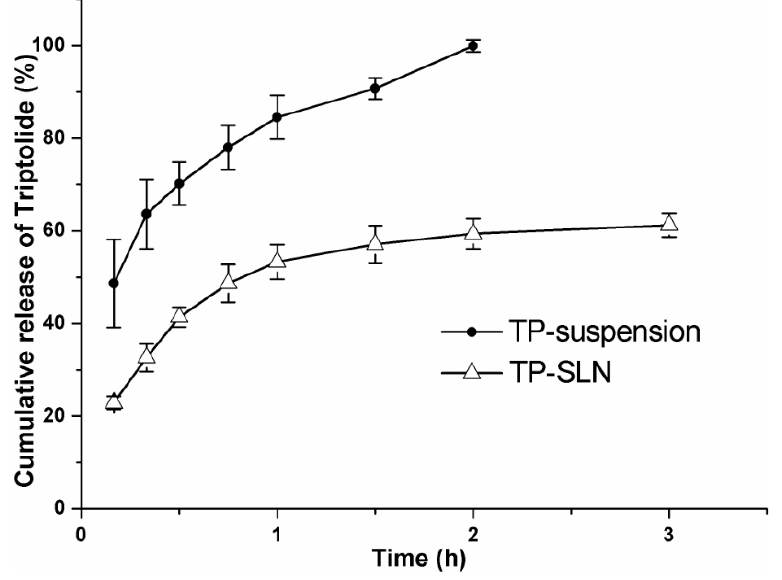
Figure 4. In vitro release profile of TP-suspension and optimized TP-SLN. 0.1 M HCl (pH 1.2) containing 10% (v/v) ethanol was selected as the release medium and the experiment was performed by the dialysis bag diffusion technique at 37 °C. Results are expressed as mean ± SD (n =